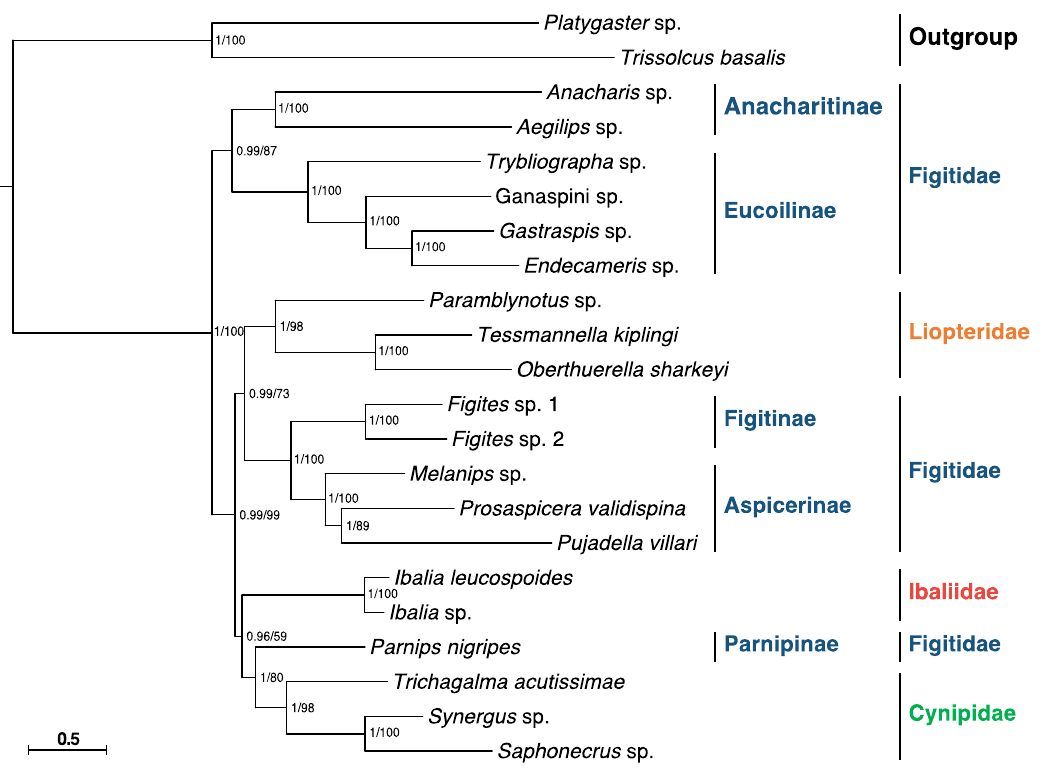
Figure 4. Phylogenetic analyses of Cynipoidea based on nucleotide datasets of 13 PCGs. The scale bar corresponds to the estimated number of substitutions per site. Numbers separated by a slash on the node are posterior probability (PP) and bootstrap value (BV).